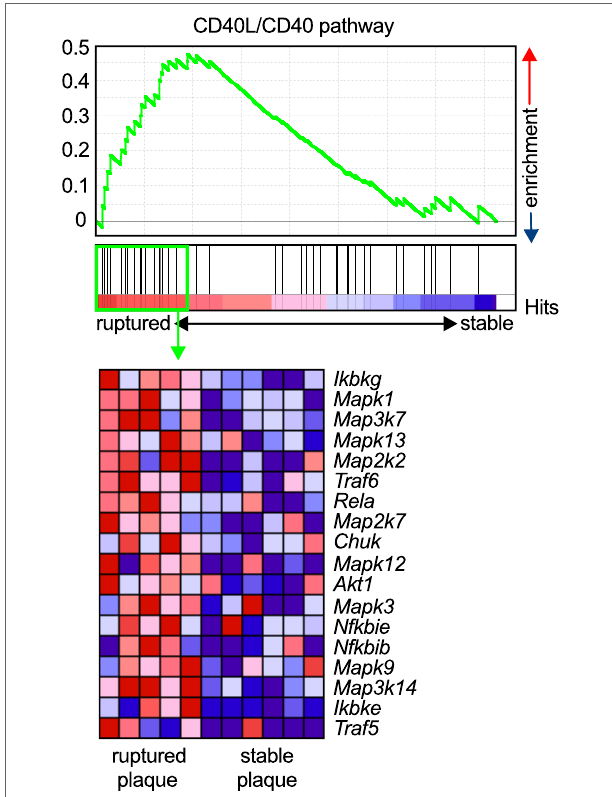
FigURe 3 | Enrichment of the CD40L/CD40 pathway in unstable human plaques. Gene set enrichment of the core CD40-signaling gene signature ( Table 3 ) was tested on published transcriptomes of human stable and ruptured atherosclerotic plaques from laser-microdissected macrophage-rich regions of carotid endarterectomy specimen. Enrichment was tested between ruptured and stable plaques. The expression of the enrichment- driving genes (lower panel) was blotted on a heatmap and colored by a row-score (blue = lowest, red = highest gene expression per